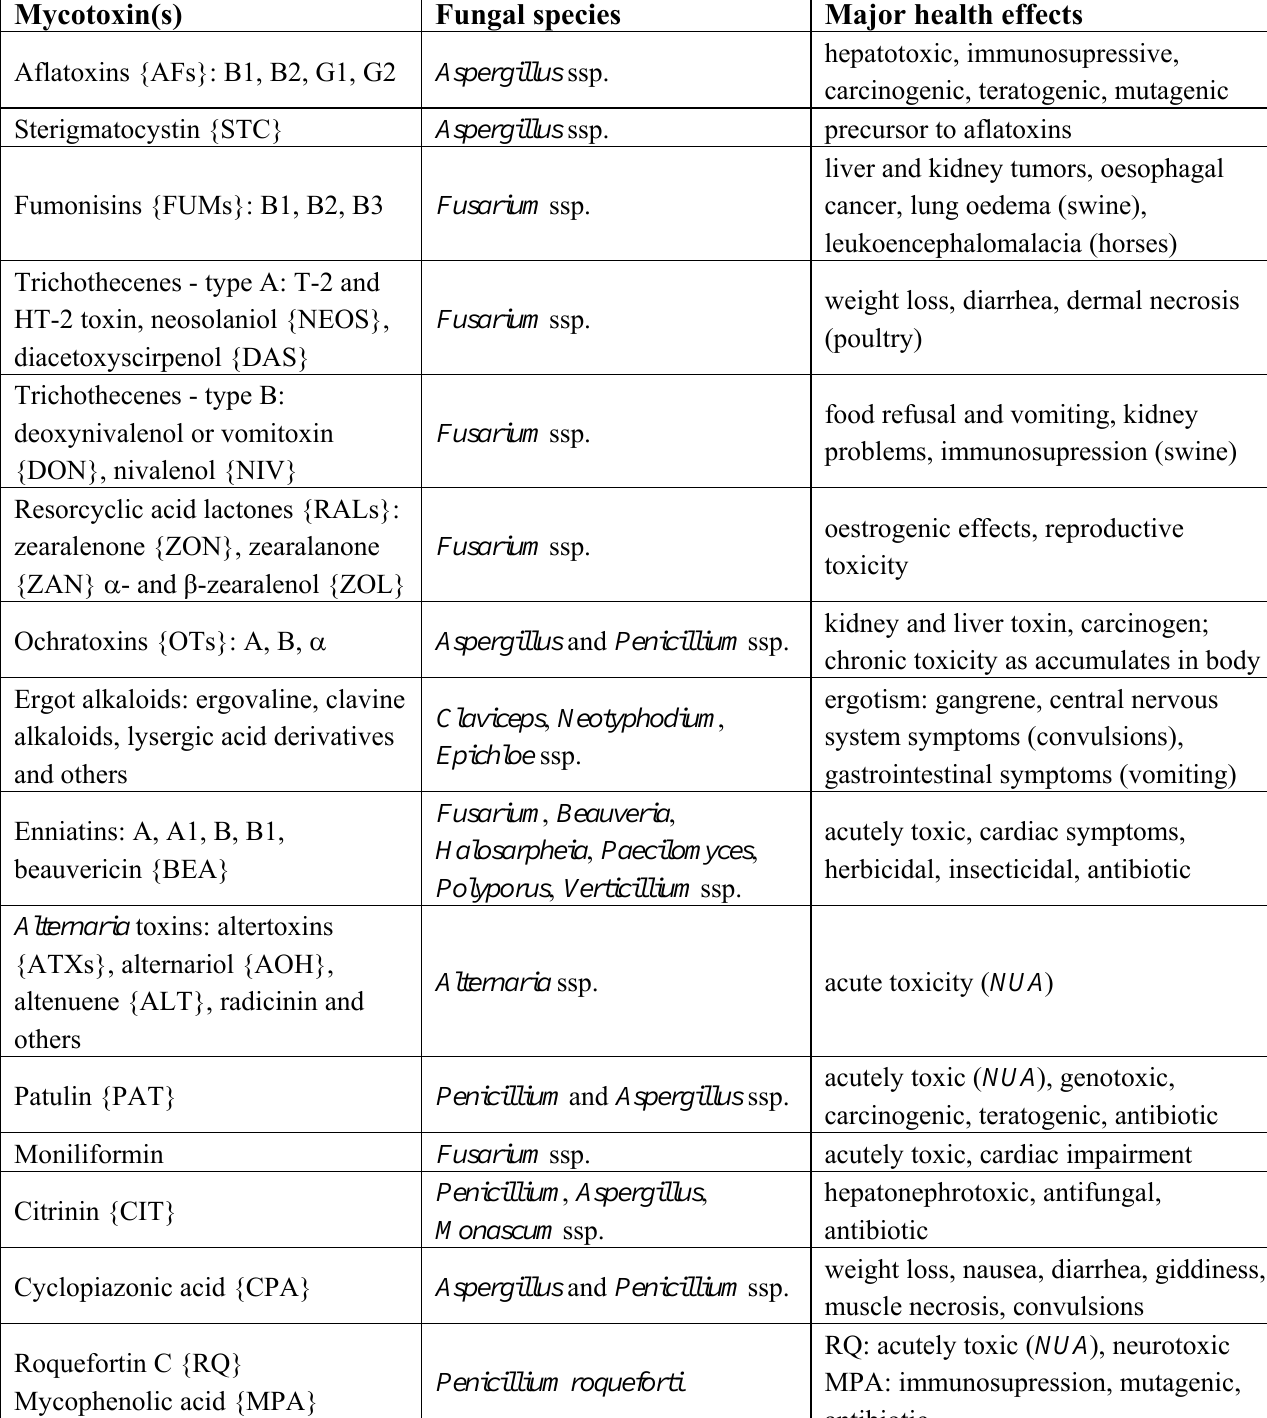
Table 1. Major mycotoxin groups or individual compounds, the fungal species producing them and health effects they cause. S ymbols for mycotoxins are written in {} curly brackets. NUA denotes “not unequivocally